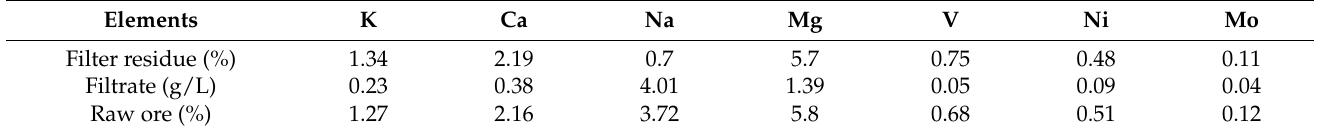
Table 7. Content of the main elements before and after